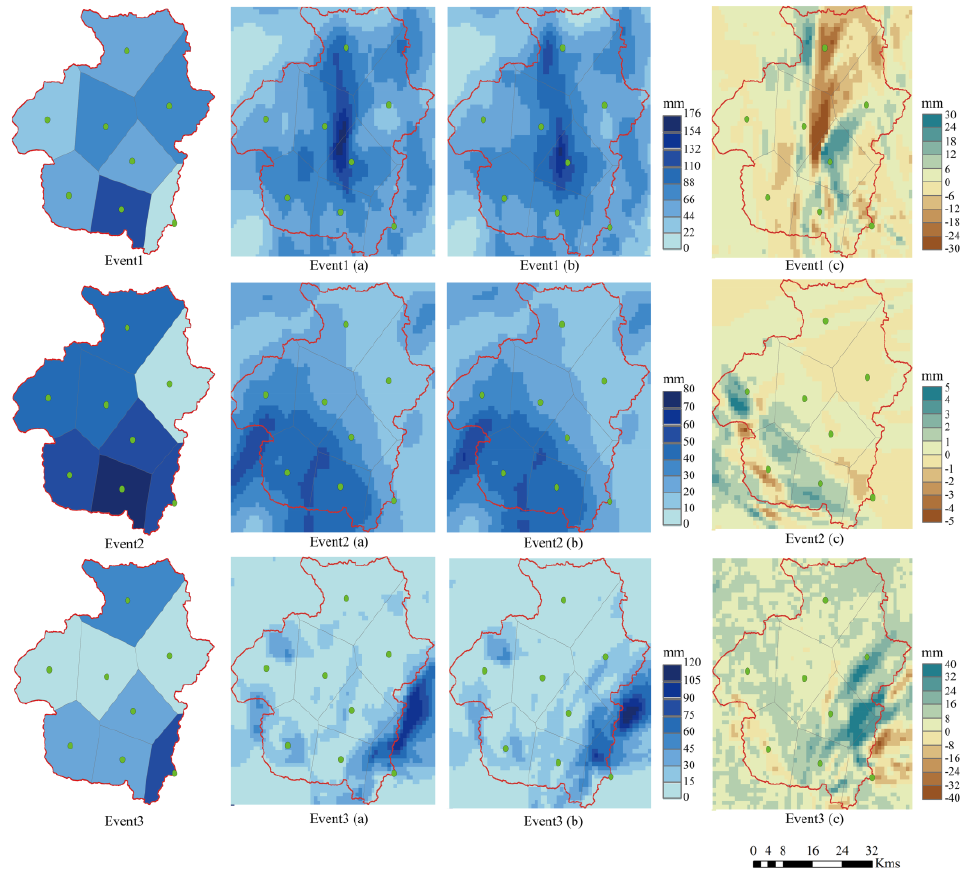
Figure 7. Spatial distributions of the 24 h accumulative rainfall for the three storm events in the Fuping catchment, from left to right: gauge observation; ( a ) WRF-only; ( b ) the fully coupled WRF / WRF-Hydro; ( c ) the fully coupled WRF / WRF-Hydro minus WRF-only.